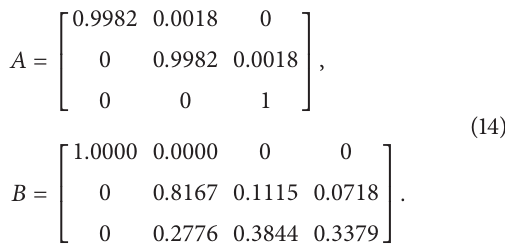
Figure8:Estimatedprobabilitydensityfunctionsforsignalsrecord- ed two, five, and eight weeks after grinding table